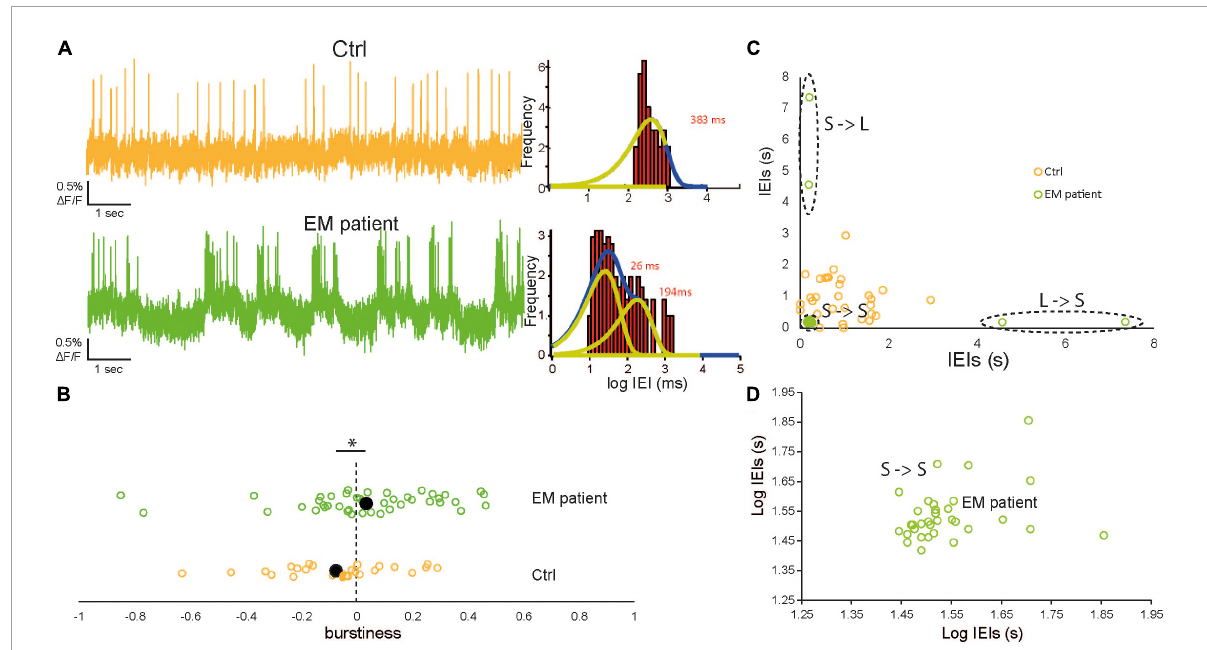
FIGURE3 Increased spontaneous bursting discharge in erythromelalgia (EM) patientdSNs. (A) Left: Representative raw imaging traces of control human induced pluripotent stem cell-derived sensory neurons (hiPSCdSNs) (top, orange) showing a sporadic firing pattern and EM patient hiPSCdSNs (bottom, green) showing a clear bursting pattern. Right: Log-binned Interevent interval (IEI) histograms of the example EM patient hiPSCdSNs trace exhibited two distributions that were well fit with multiple exponential distributions whereas control hiPSCdSNs were well fit with a single exponential. Yellow lines indicate exponential fits. Blue lines indicate the sum of the fits. (B) Comparison of the burstiness of EM patient hiPSCdSNs and control hiPSCdSNs. Filled black dots indicate the average values. Burstiness is significantly higher in EM patient hiPSCdSNs ( EM patientdSNs N = 45, control hiPSCdSNs N = 27; WRT ∗ p = 0.04). (C) Plot of the shifted IEIs for single cell examples of EM patient hiPSCdSNs and control hiPSCdSNs. Dotted black lines indicate clusters of short followed by short (S- > S) Short followed by long (S- > L) and L- > S in the